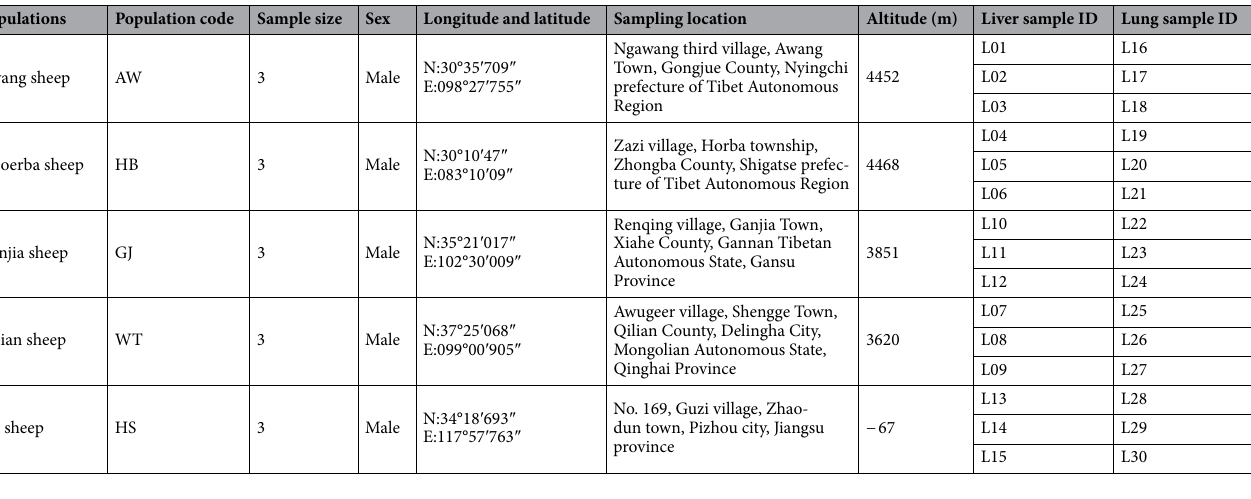
Table 1. Sampling information of five sheep populations ( Ovis aries ) for transcriptome analysis. The number of altitude only refers to the value in sampling location, more animal samples from the same area were used for physiological and biochemical